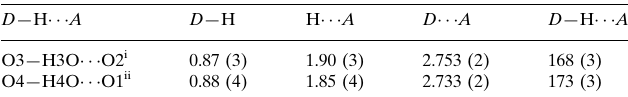
Hydrogen-bond geometry (A˚ , (cid:1)